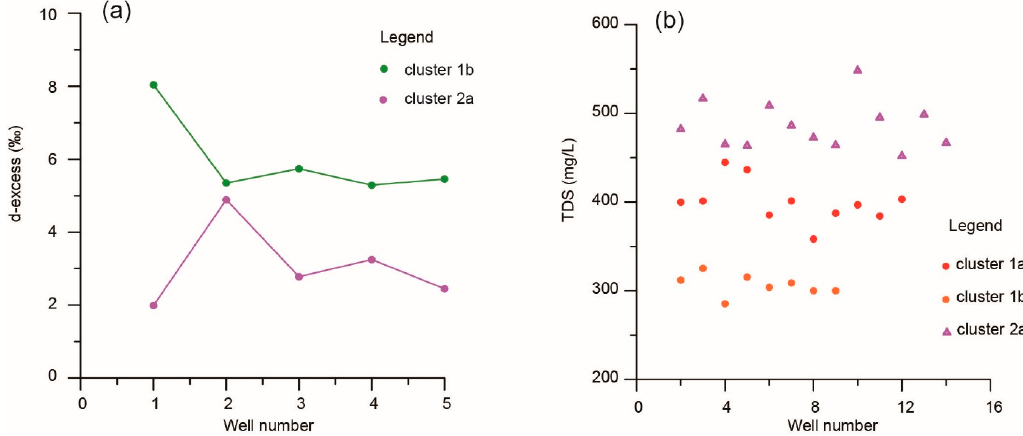
Figure 8. Scatter plot for ( a ) d-excess of cluster 1a and 2a and ( b ) TDS of cluster 1a, 1b, and